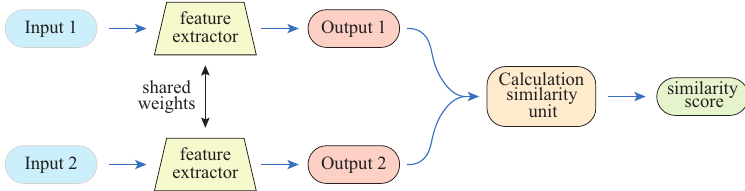
Figure 2. Illustration of the Siamese